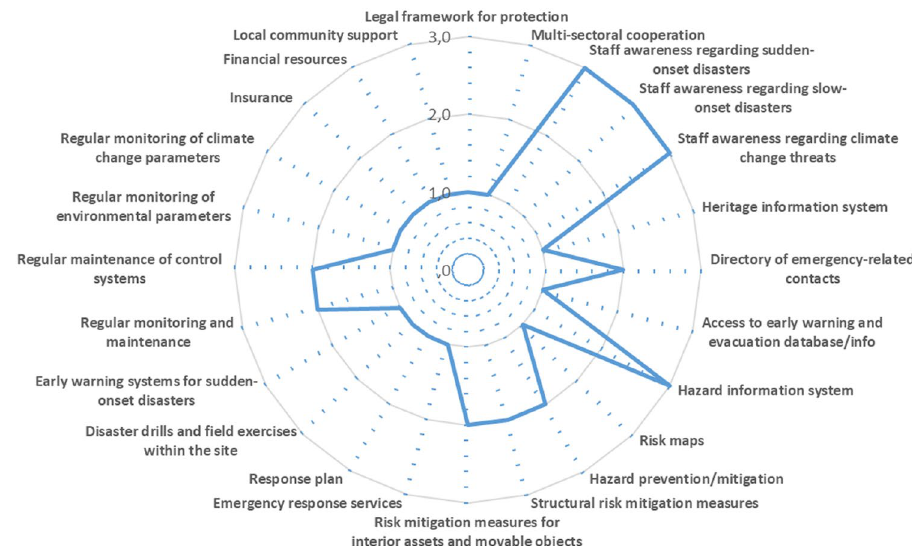
Fig. 4 Analysis of the coping/ adaptive capacity indicators for